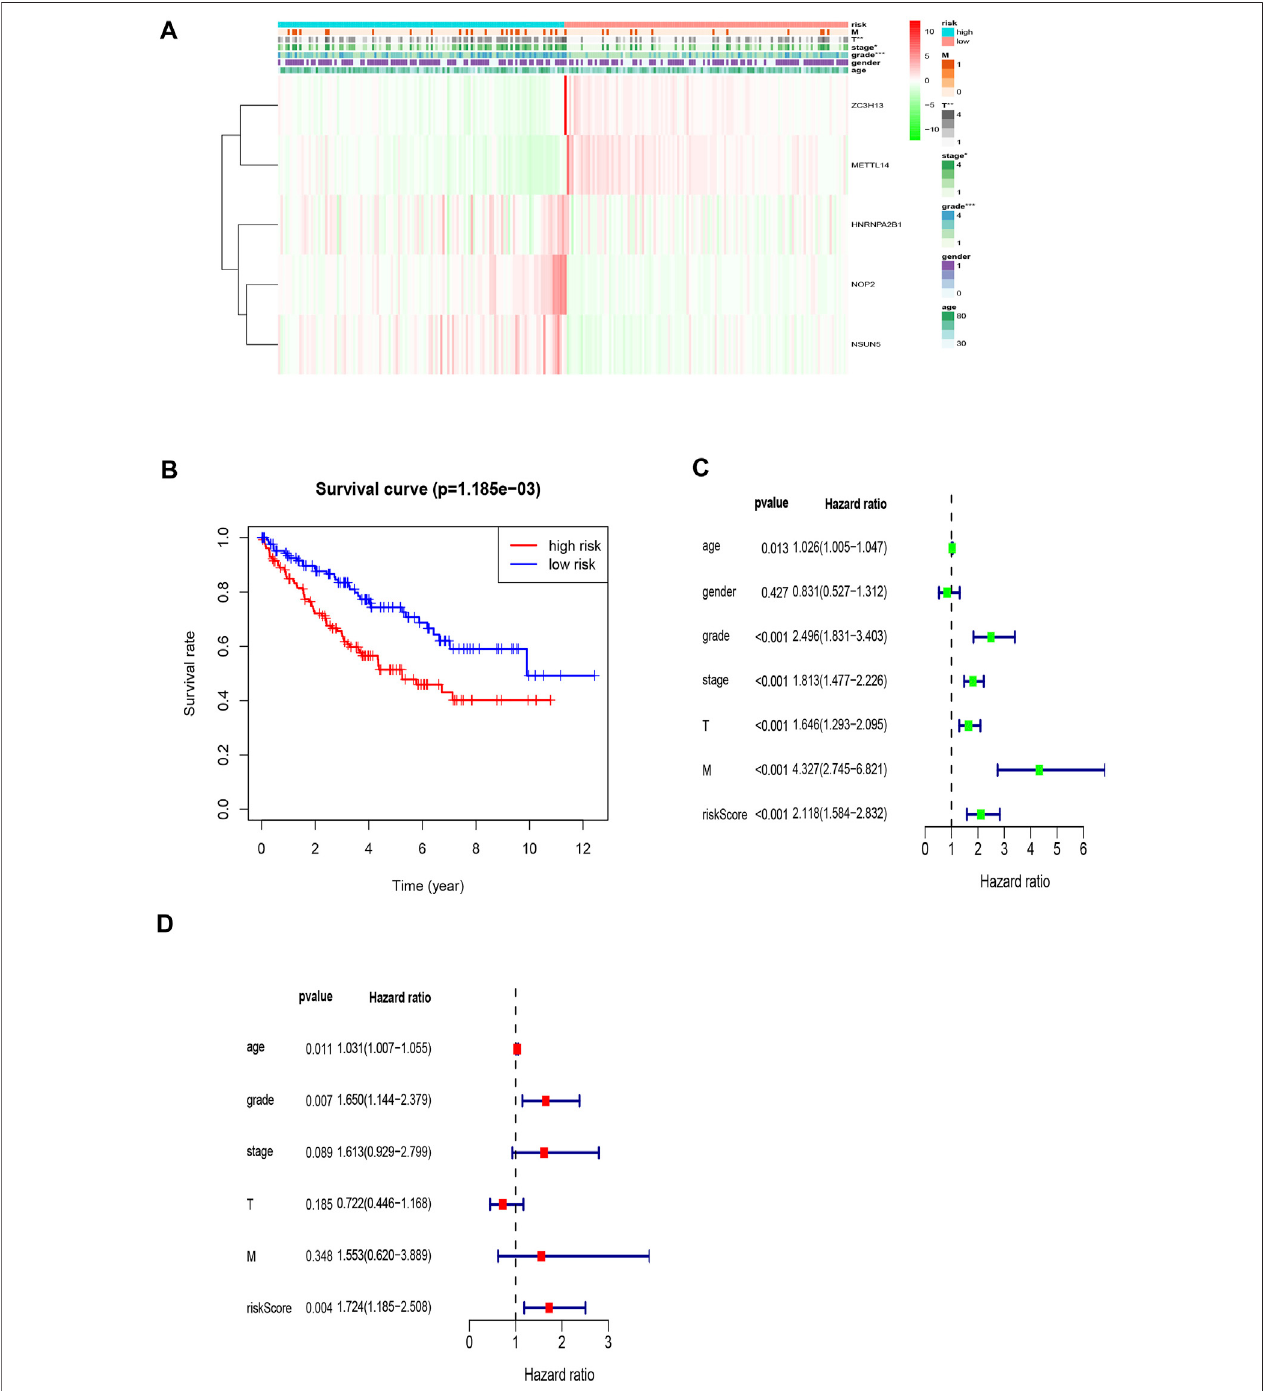
FIGURE 5 | Prognostic signature of the fi ve related regulators in the validation set and the training set of independent prognostic factors for KIRC OS. (A) The validationsetoftheheatmapoftherelationshipbetweenthegeneexpressionofthecorresponding fi veregulatoryfactorsandclinicalfeatures. (B) Kaplan – Meiersurvival curves for OS in the two groups of low and high risk. This analysis was based on the survival information of samples in the validation set. (C,D) Forrest plot of the independent prognostic factors in KIRC.